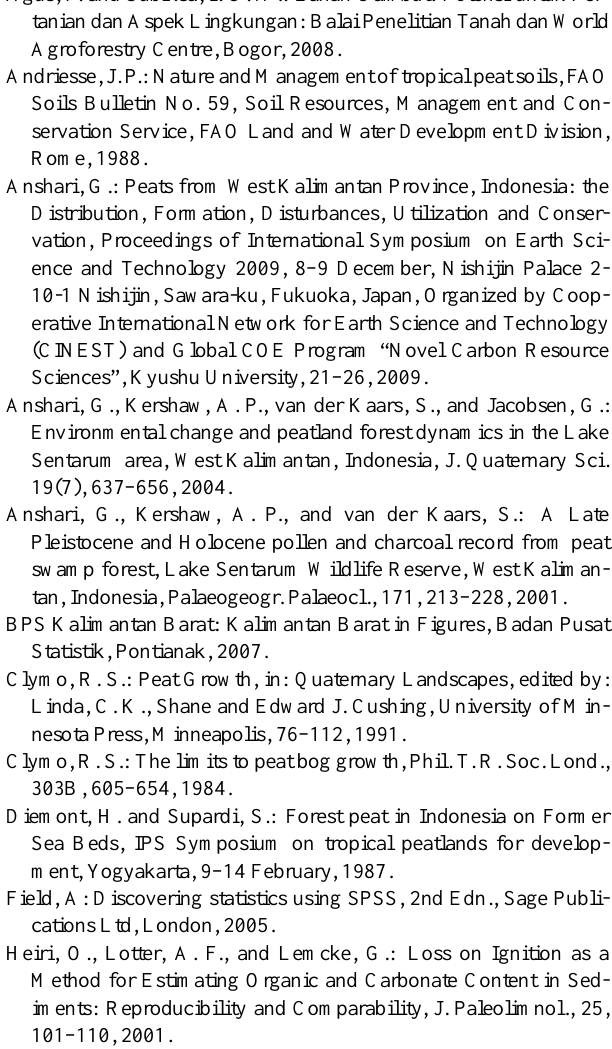
Fig. 7. A scatted plot LOI vs. TOC in the upper 200cm depth from Sebangau Peat Forest, Central Kalimantan (Modified from Page et Figure 7. A scatted plot LOI vs TOC in the upper 200 cm depth from Sebangau Peat Forest, al., Central Kalimantan (Modified from Page et al., 2004)